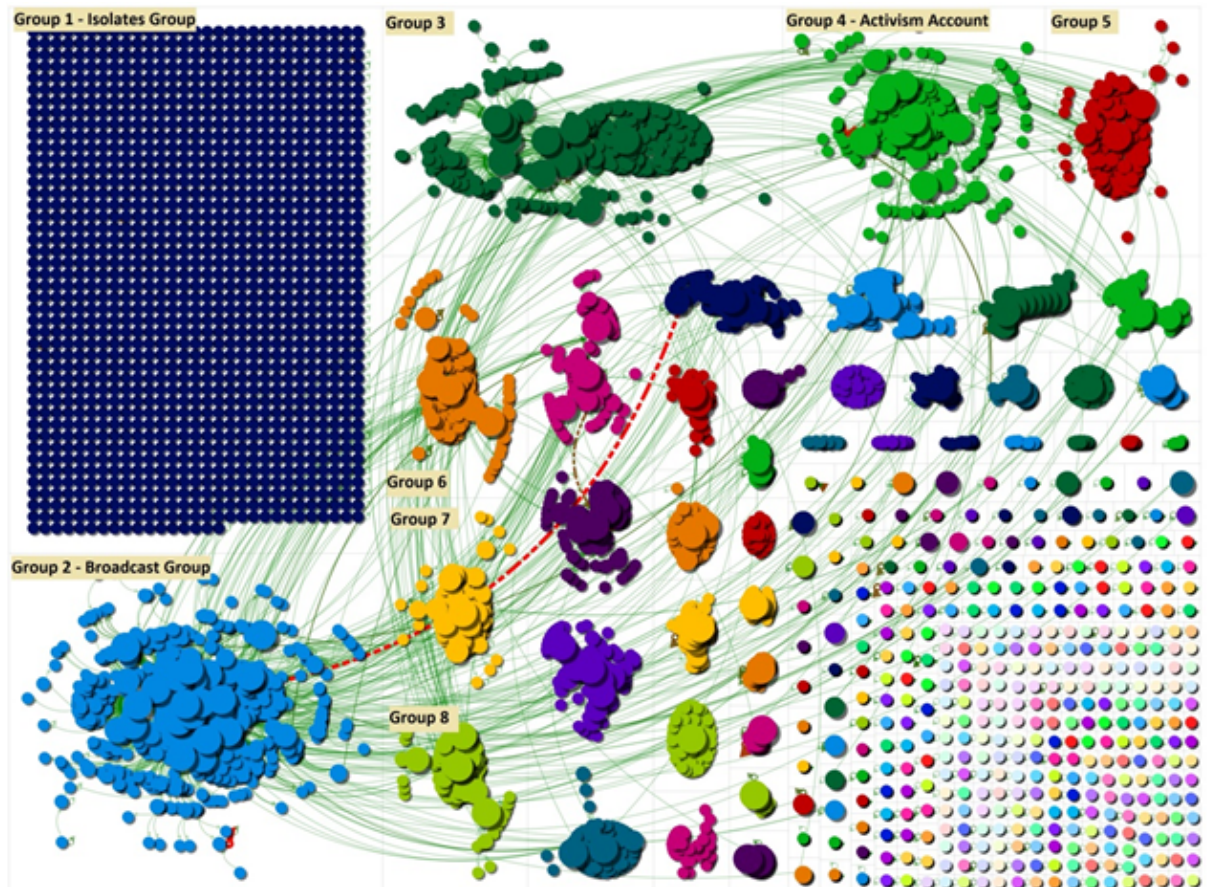
Figure 1. Social network graph of